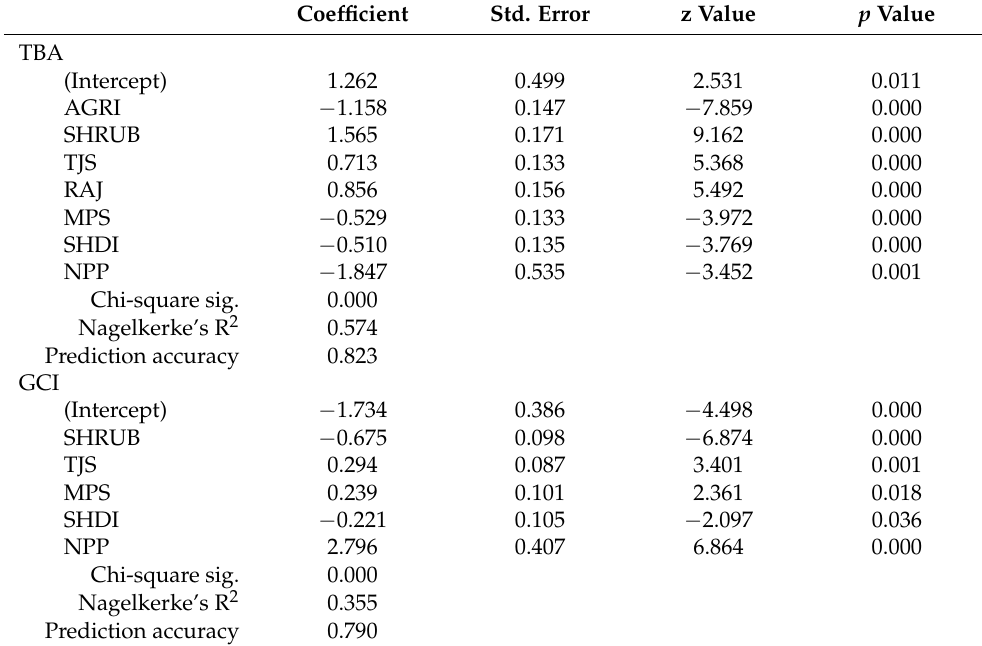
Table 2. Coefficients and statistics for the final TBA and GCI